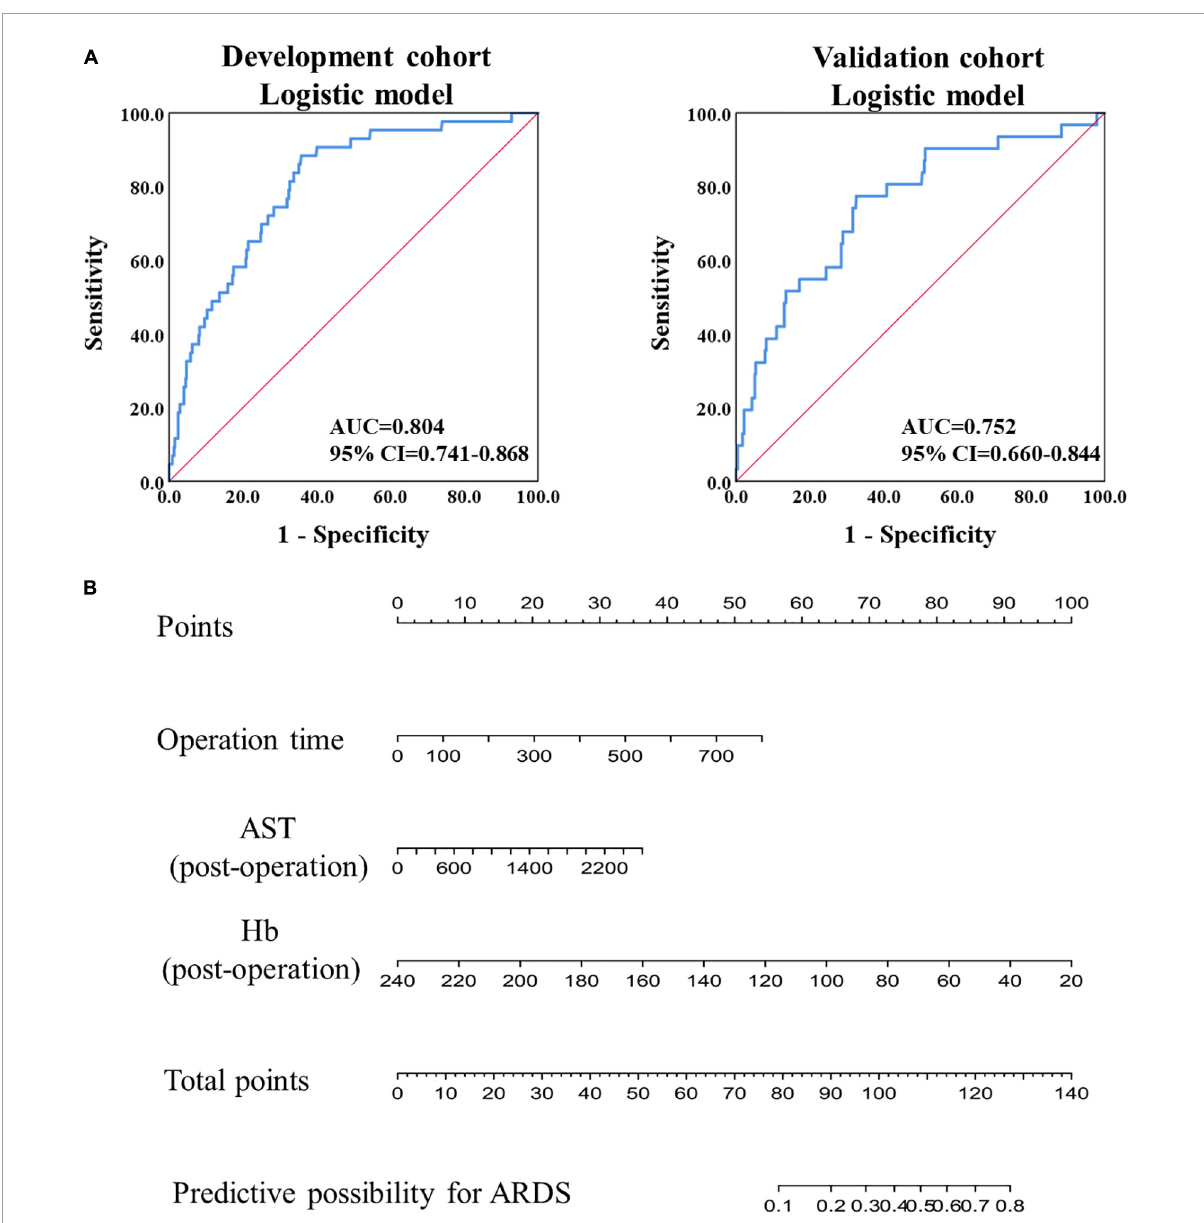
FIGURE1 Model construction and validation based on logistic regression. (A) The ROC analysis of the prediction model in the development and validation cohorts. (B) The nomogram of prediction model based on the logistic regression in the development